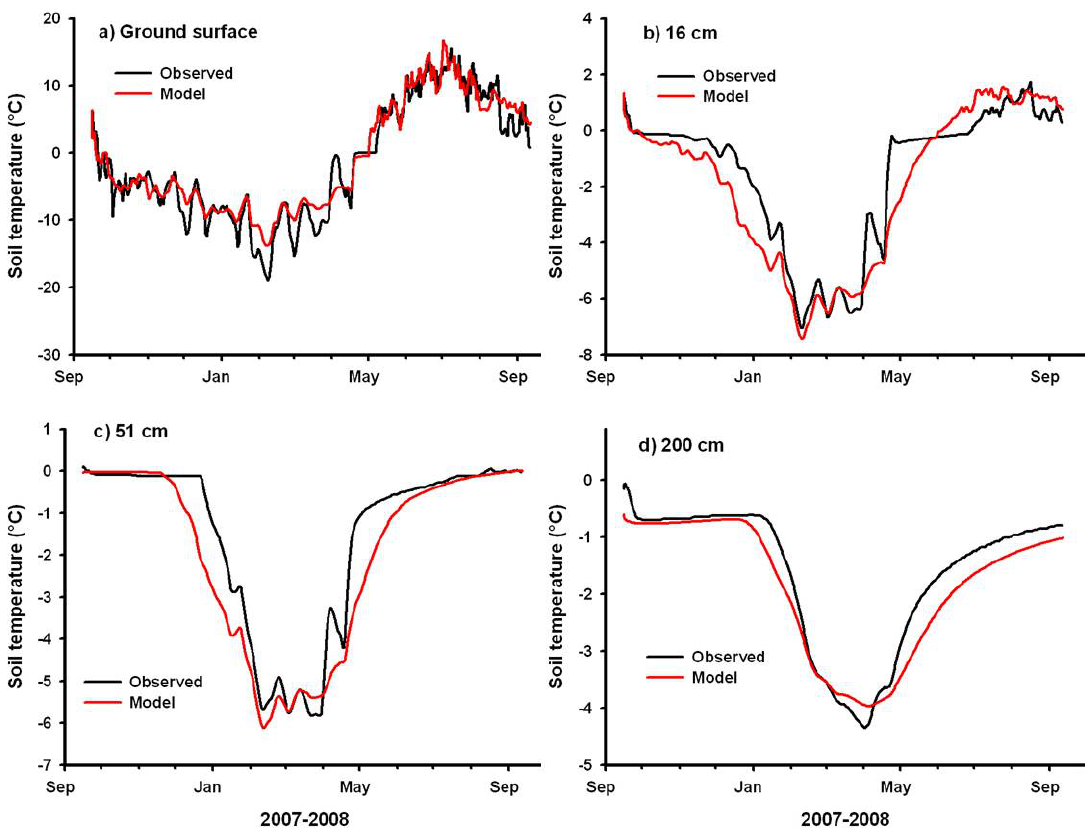
Fig. 3. Comparison of model soil temperature outputs (from GIPL2) and observed soil temperatures at different depths at the unburned mature site near Hess Creek. Model was separately parameterized for 2003 Burn and 1967 Burn soil